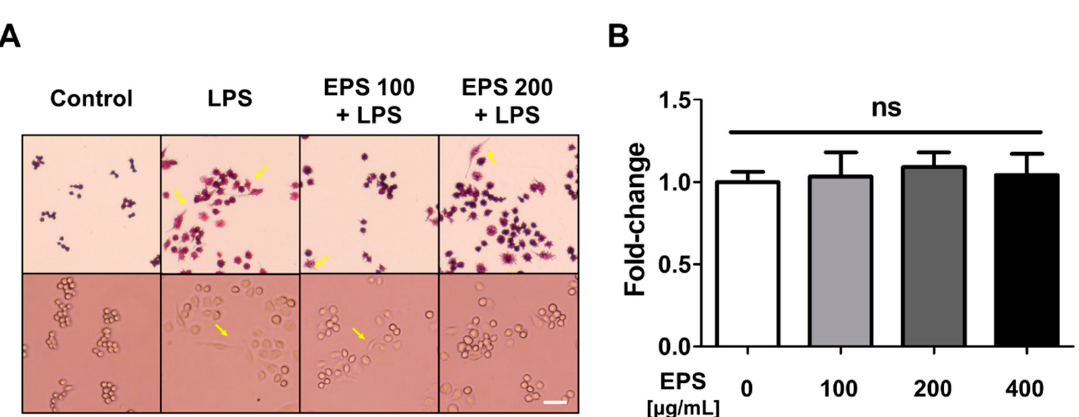
Figure 3. The purified EPS could alleviate the morphological changes induced by LPS in RAW 264.7 cells. ( A ) Cells pretreated with EPS were cultured with fresh media containing LPS and stained with crystal violet. EPS pretreatment inhibited the LPS-induced morphological changes, as indicated by the yellow arrow. ( B ) EPS treatment did not have any effect upon cell viability after 1 day. Scale bar = 50 μ m; ns, not significant.